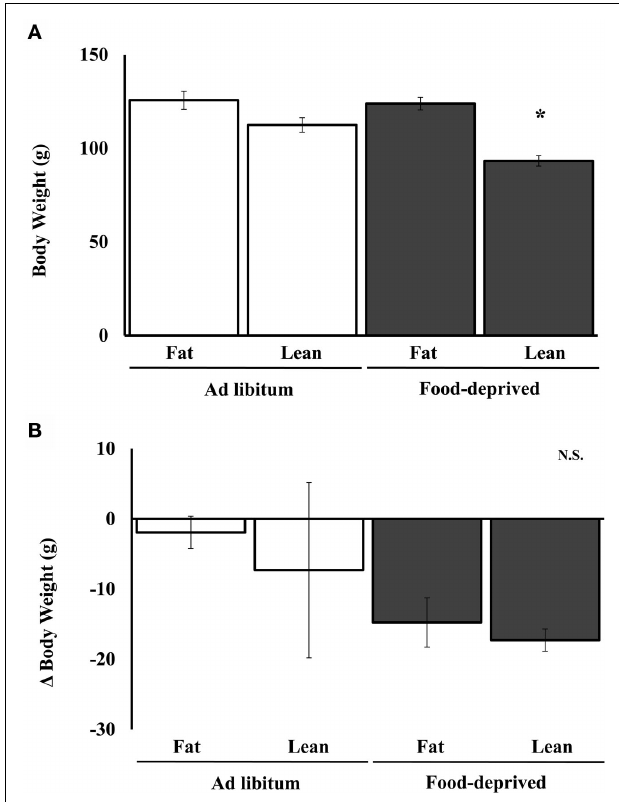
FIGURE 5 | Mean and SE of the mean for (A) . body weight of ad libitum -fed or food-deprived female hamsters that were lean or fat prior to the start of food deprivation and (B) . change in body weight of the same females after food deprivation in Experiment 2A. *Significantly different from ad libitum at P <